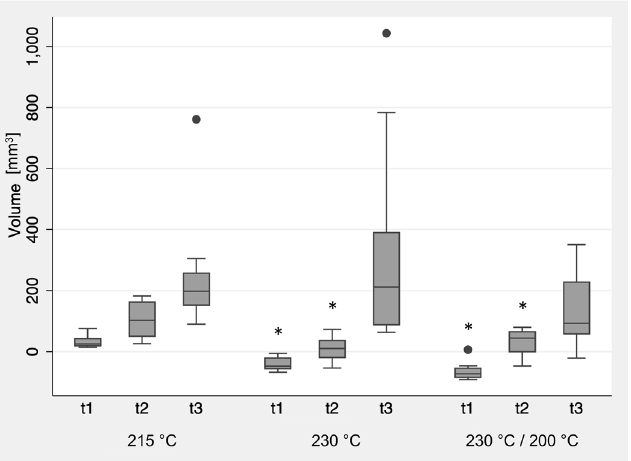
Figure 6. Influence of nozzle temperature on the dimensional changes of group At after 3D printing (t1), annealing (t2), and steam sterilization (t3) compared to the original STL file. Asterisks (*) indicate the significance to standard printing temperature of 215 °C at the respective time point.